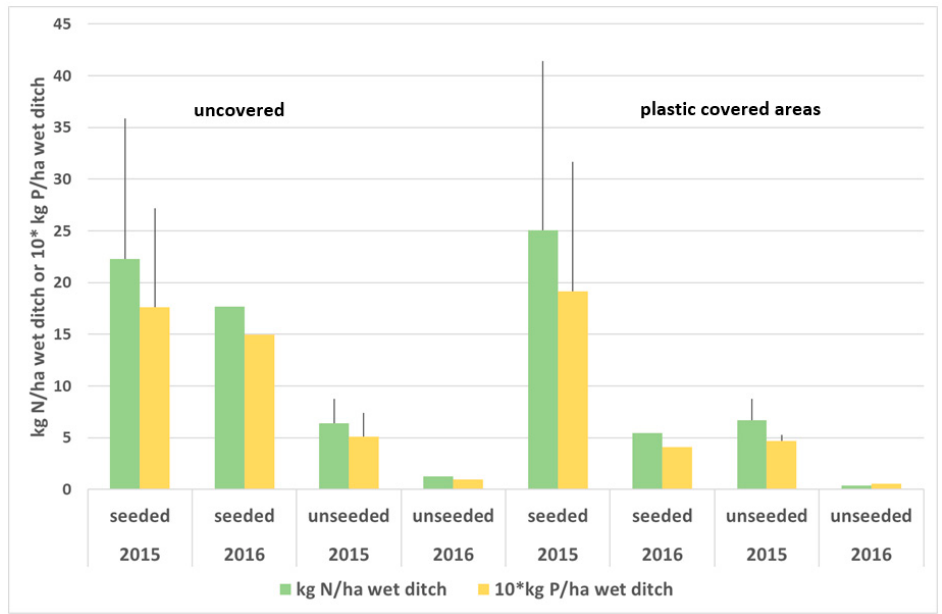
Figure 5. Average dry matter content and SD of above-ground growth in the seeded and unseeded ditches, for June 2015 and May 2016, uncovered and plastic covered areas, per unit wetted area of ditch. Width of the wet ditches is assumed to be 0.5 m. The SD of watercress DM is also shown ( n = 5).